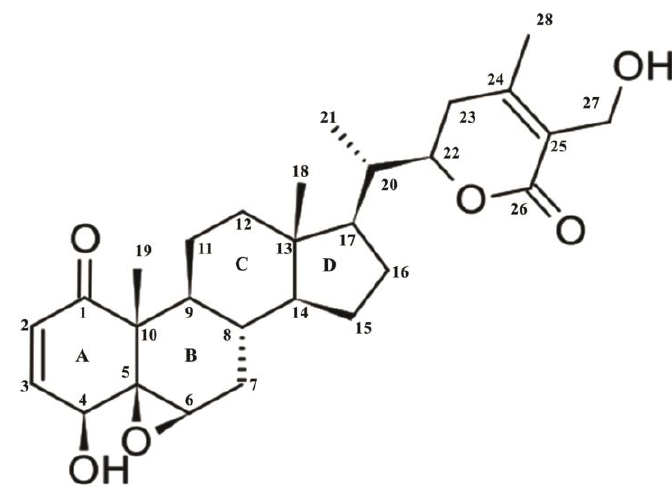
Figure 1. Structure of withaferin A.